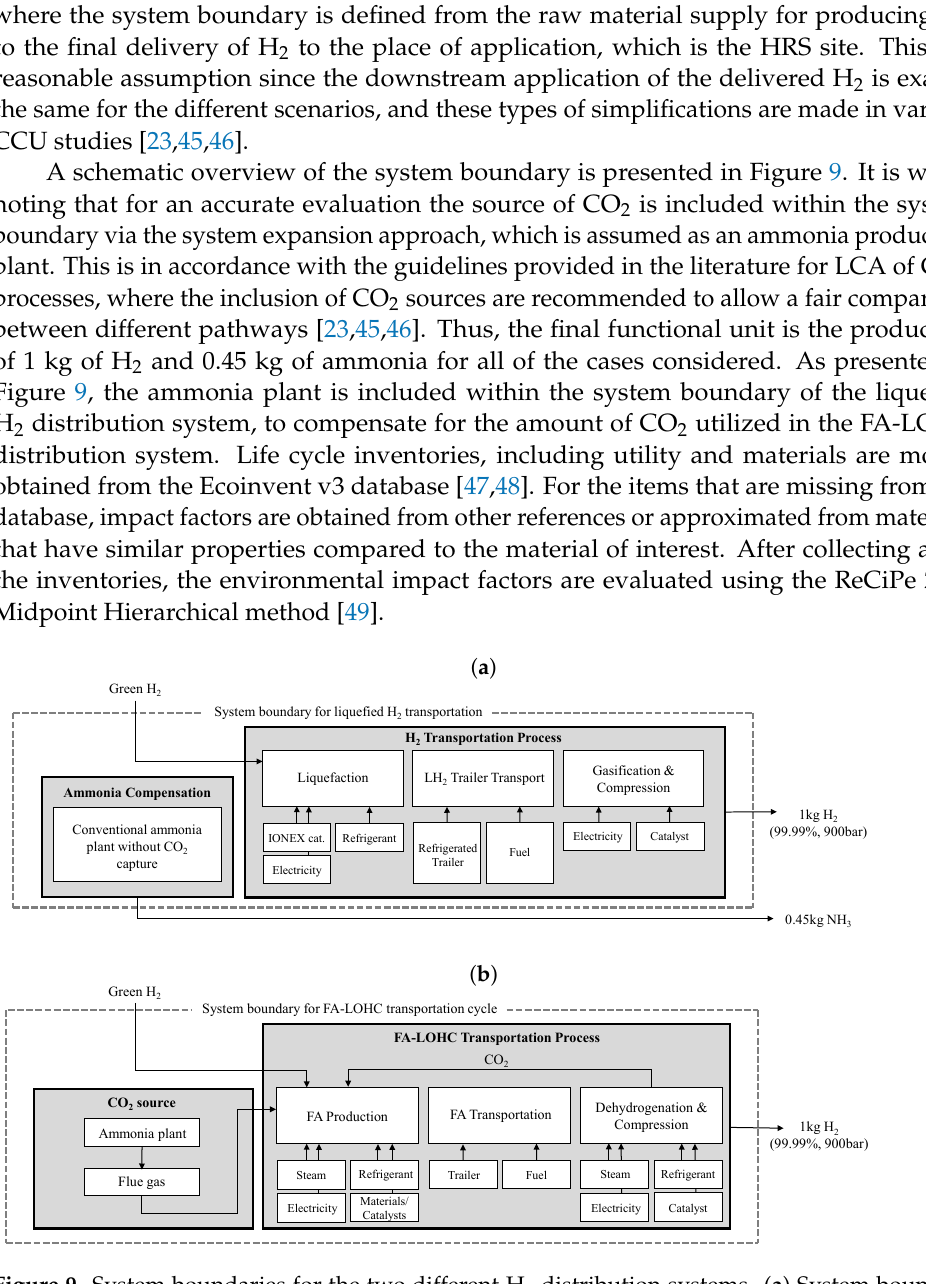
Figure 9. System boundaries for the two different H 2 distribution systems. ( a ) System boundary for the liquefied H 2 distribution system. An ammonia plant is included by the procedure of system expansion to compensate for the CO 2 production source, and ( b ) system boundary for the FA-LOHC distribution system. An ammonia plant is included as the source for CO 2